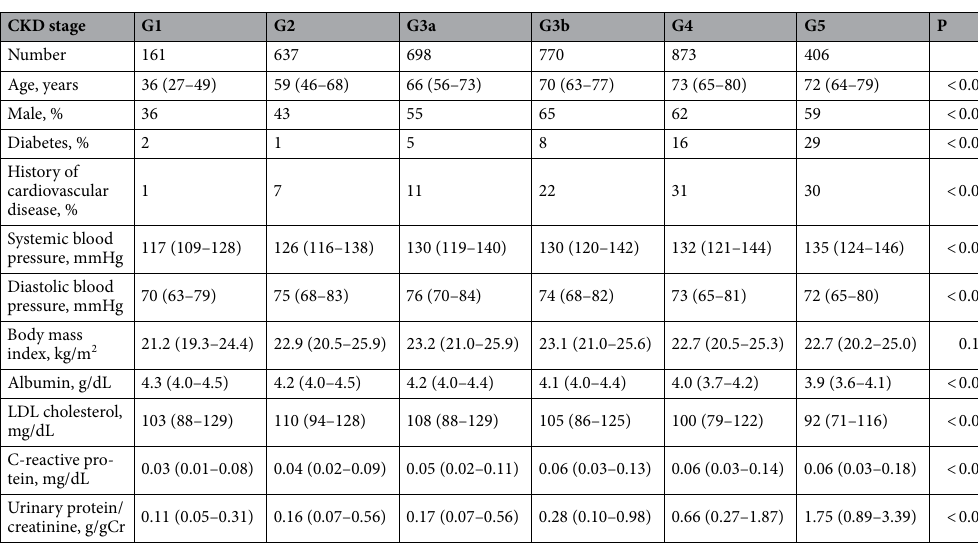
Table 1. Baseline characteristics according to CKD stage. CKD, chronic kidney disease; Cr, creatinine; LDL, low-density lipoprotein; s.e., standard error .